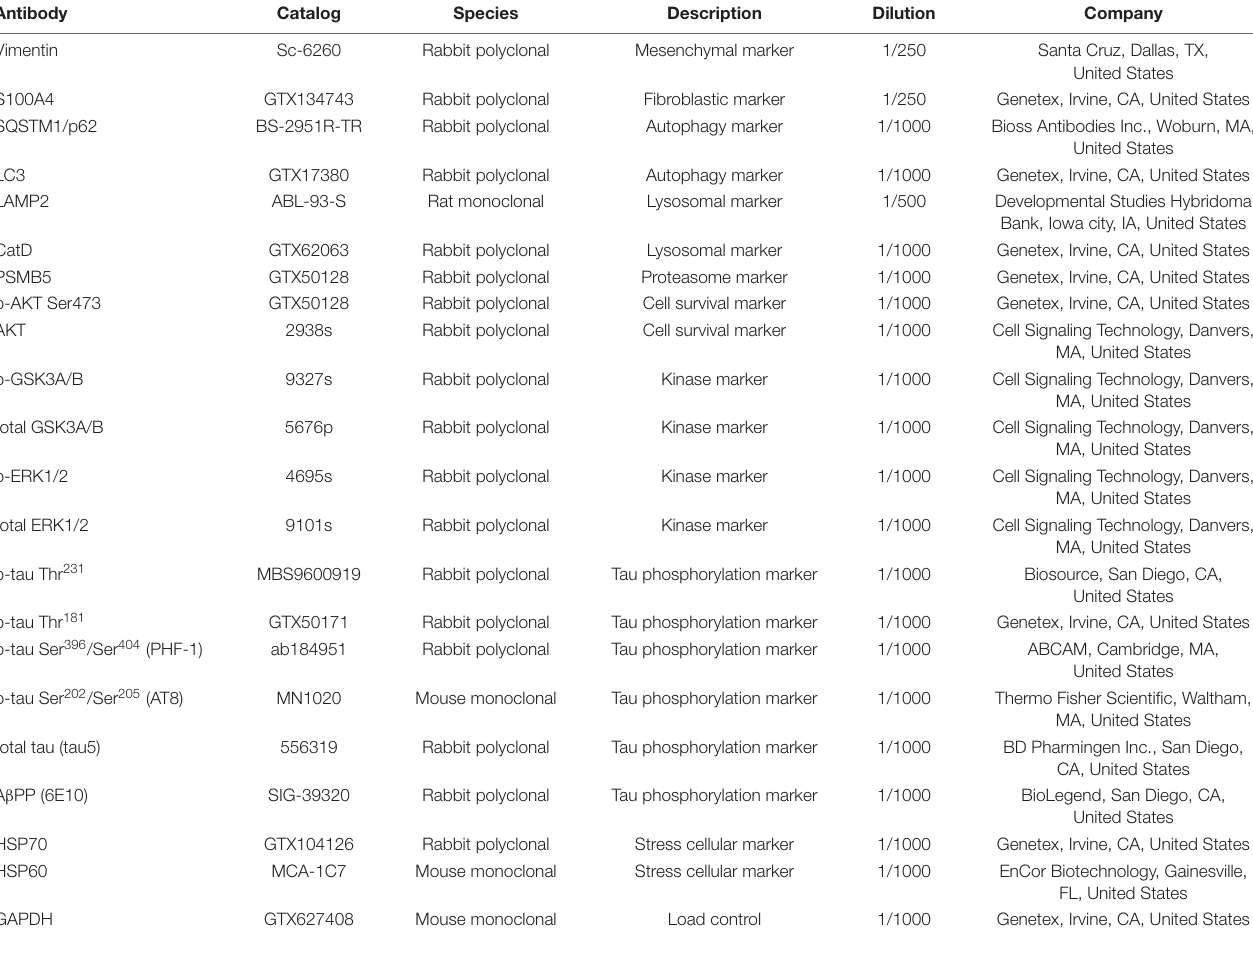
TABLE 2 | Antibodies used in immunofluorescence and western blot